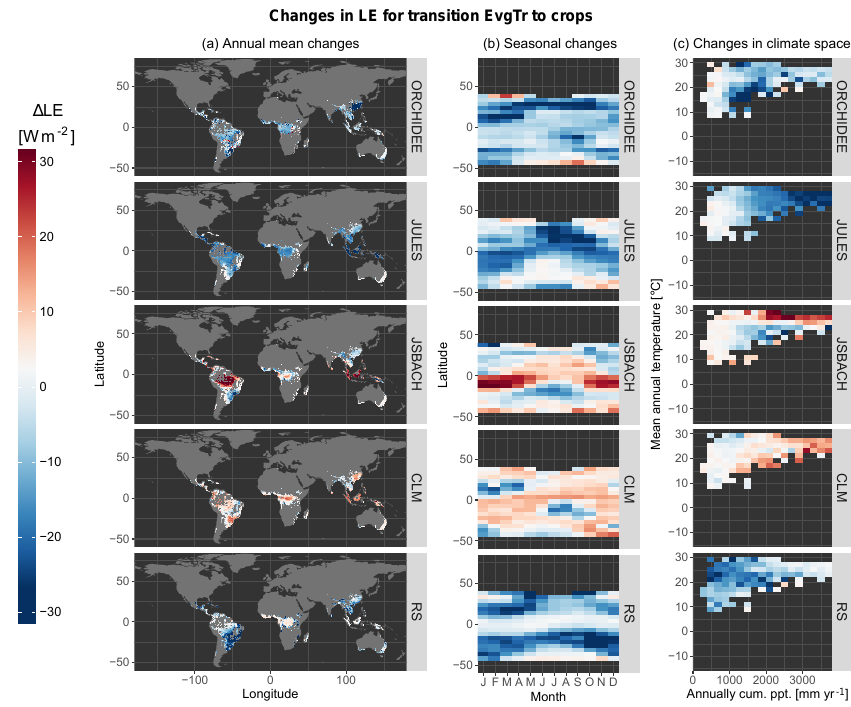
Figure 2. Inter-comparison of how the land surface models and remote sensing (RS) estimate a change in latent heat flux (LE) for the vegetation transition from evergreen broadleaf trees to crops (Crops – EvgTr). We summarize the data within three different comparison spaces to illustrate (a) the spatial variability, representing the annual mean for each pixel; (b) the seasonal variability; and (b) the variability in climate space, represented by mean annual temperature and annually cumulated